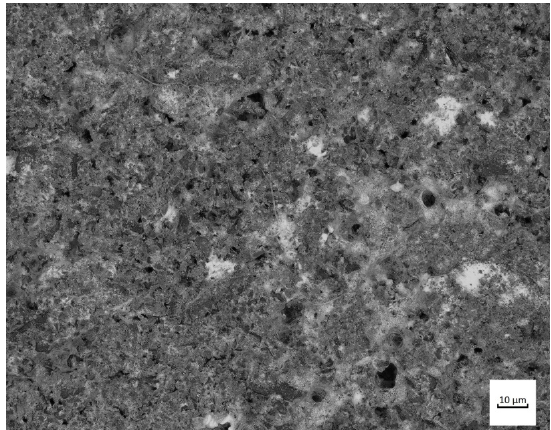
Figure 2. Surface of nitride-bonded silicon carbide. Table 2. Chemical composition of the material under study. Table 3. Properties of silicon carbide.